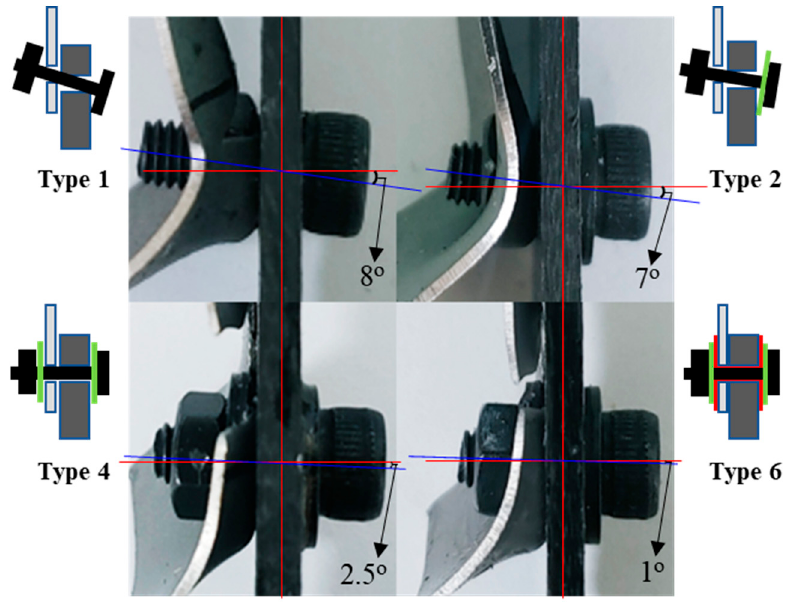
Figure 6. Deformation of the joining segment with the washer and adhesive. (red line: vertical and horizontal axis, blue line: axis by bolt thread).